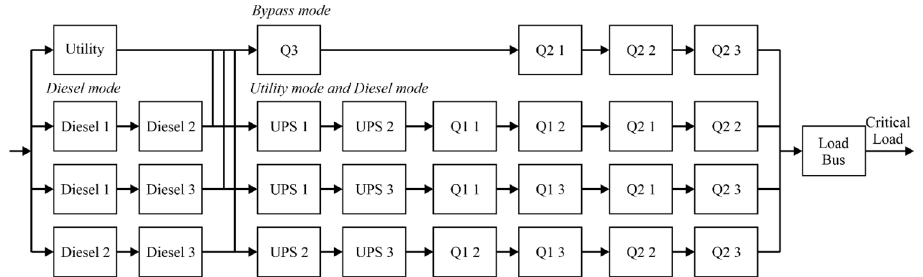
Figure 6. An example of an RBD diagram for a PS configuration.